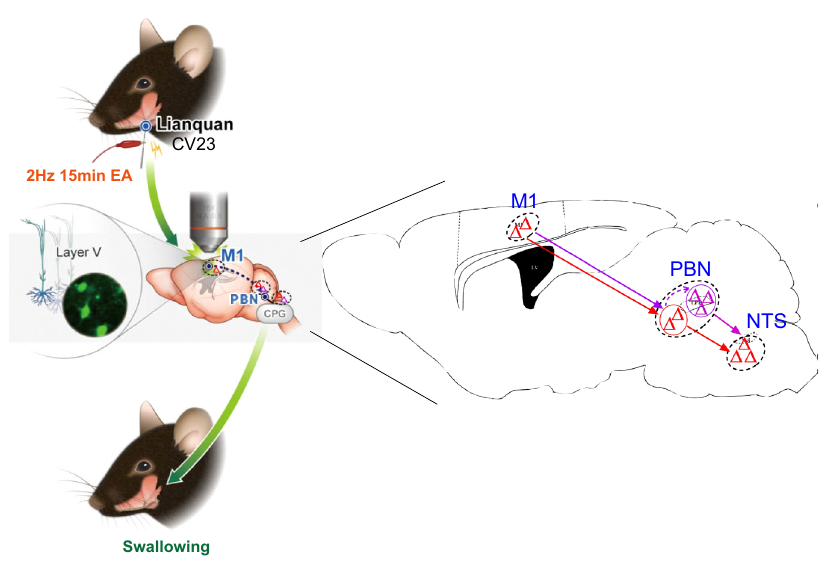
Fig. 7 | Diagram of the mechanism underlying the effect of EA-CV23 on PSD treatment. ExcitatoryneuronsinthecontralateralM1L5arerequiredforEA-CV23- mediated alleviation of swallowing dysfunction in PSD model mice. This